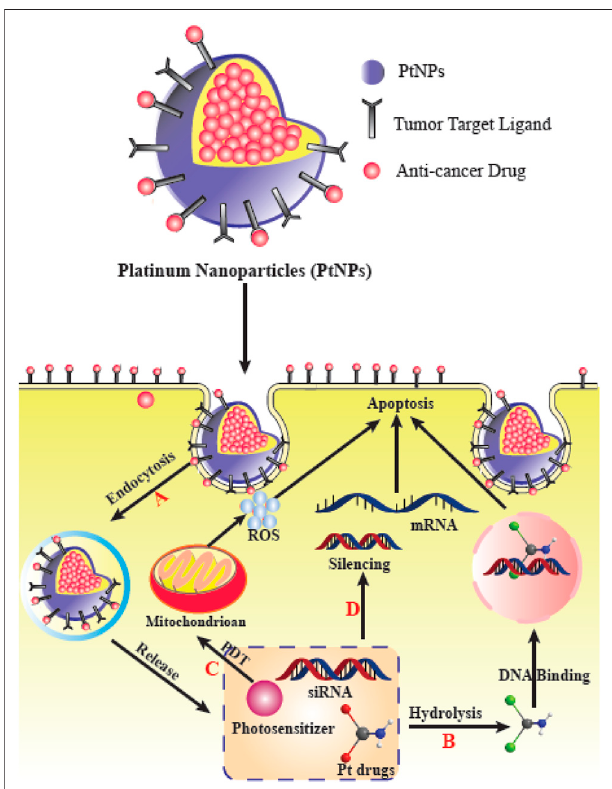
FIGURE 7 | PtNPs for delivery of various therapeutic agents and their effects in cancer cells. (A) PtNPs improve cellular uptake via endocytosis to circumventthelimitoftransporters. (B) PtNPswithotherchemotherapydrugs to achieve a synergistic effect. (C) PtNPs with photodynamic therapy (PDT). (D) Co-delivery PtNPs with siRNA can silence the drug-resistance- related genes. This fi gure adapted from Xie et al.